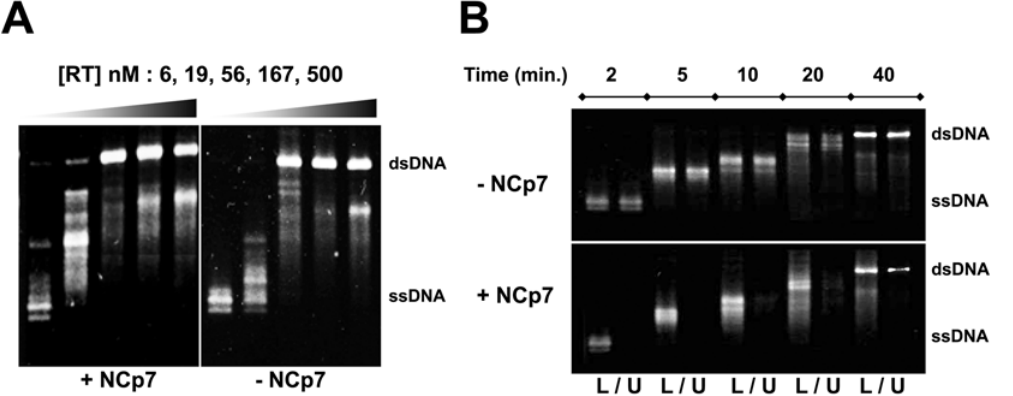
Figure 3. Comparison of DNA synthesis by RT in the absence and presence of NCp7. (A) The progression of DNA synthesis is shown with or without NCp7 for a reaction time of 30 min. as a function of RT concentration. (B) The reaction is shown as a function of time with or without NCp7 for a fixed concentration of RT. The DNA products (B) have been sedimented before electrophoresis. Lower (L) and upper (U) half-volumes collected after sedimentation are indicated underneath. Concentrations of ssDNA and NCp were, respectively, 5 nM, 3.4 m M (A and B) and RT was 50 nM (B). DNA and NCp7 were premixed for 4 min. at 37 u C, following incubation with RT for 2 min. before addition of dNTPs (100 m M each) to start the